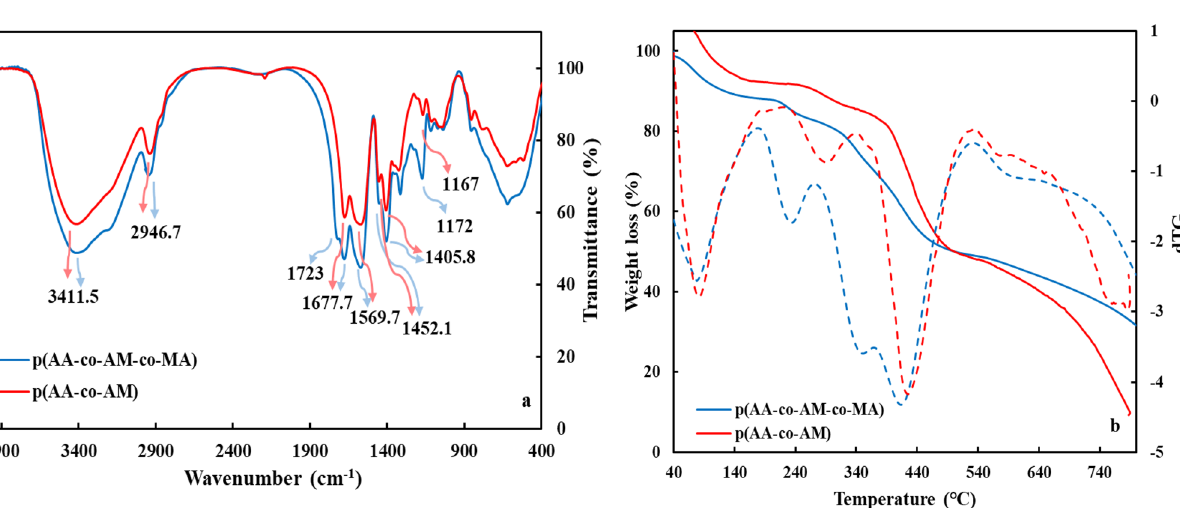
Figure 2. ( a ) FT-IR spectra of p(AA-co-AM-co-MA) and p(AA-co-AM), and ( b ) TGA and dTG of p(AA-co- AM-co-MA) and p(AA-co-AM)